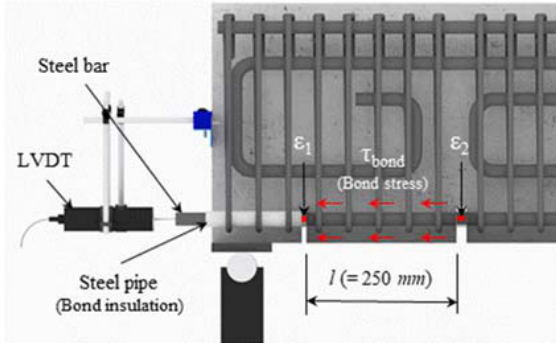
inner and corner longitudinal reinforcements was about 2 mm. Then, as the slip signifi ‐ Figure 12. Measuring method of slip. cantly increased, bond degradation also considerably occurred, decreasing the stress by Figure 12. Measuring method of slip. bond failure. As shown in Figures 11 and 13, regardless of the replacement ratio of ground granu ‐ lated blast furnace slag, flexural cracks were found in the B series specimens at the crack ‐ inducing grooves located at the boundary of the experimental zone in the early stage of the loading. As the load increased, flexural cracks increased, and many bond cracks were found in the experimental zone. When the maximum bond stress was reached, slip of the